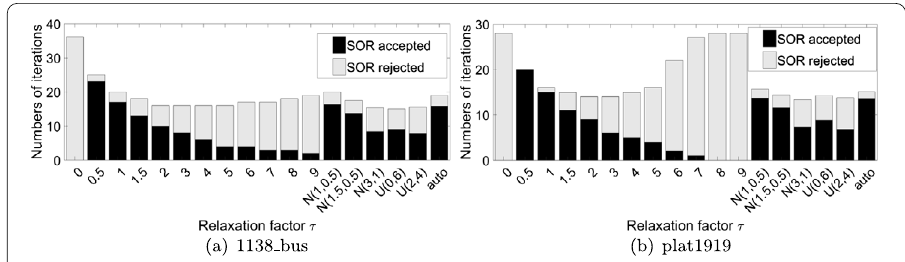
Figure 6 Comparison of the numbers of iterations for various values of relaxation factor τ with classic multidimensional scaling as the initial